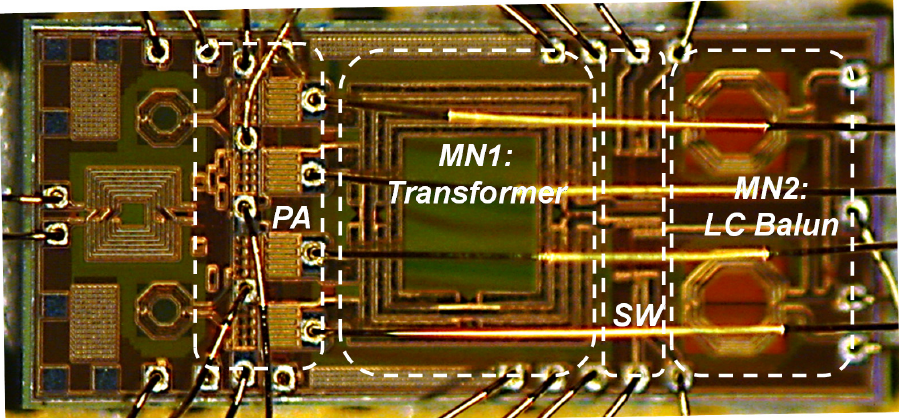
Figure 19. Microphotograph of the proposed structure.